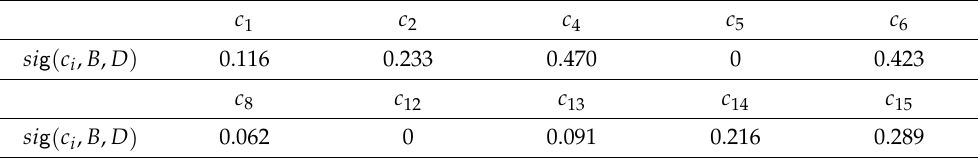
Table 5. Classification ability of left drum condition attribute c for B to D